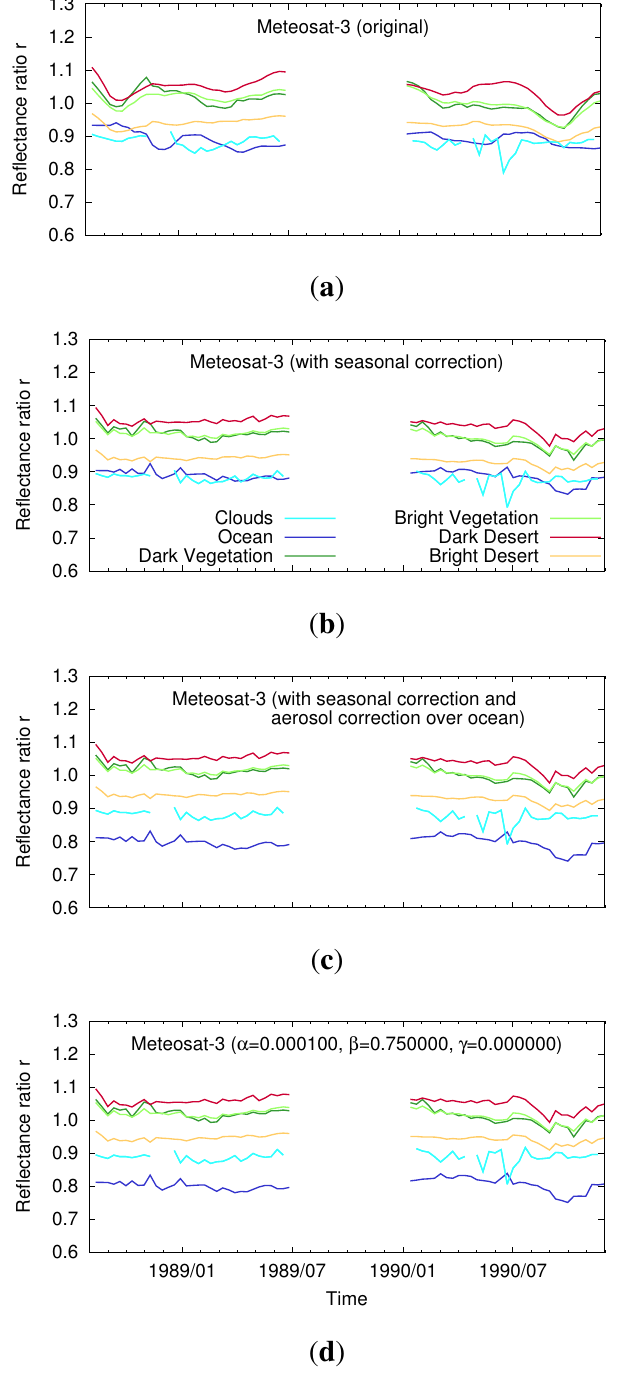
Figure 8. Meteosat-3 time series ( a ) original; ( b ) after seasonal correction; ( c ) after aerosol correction; and ( d ) after ageing